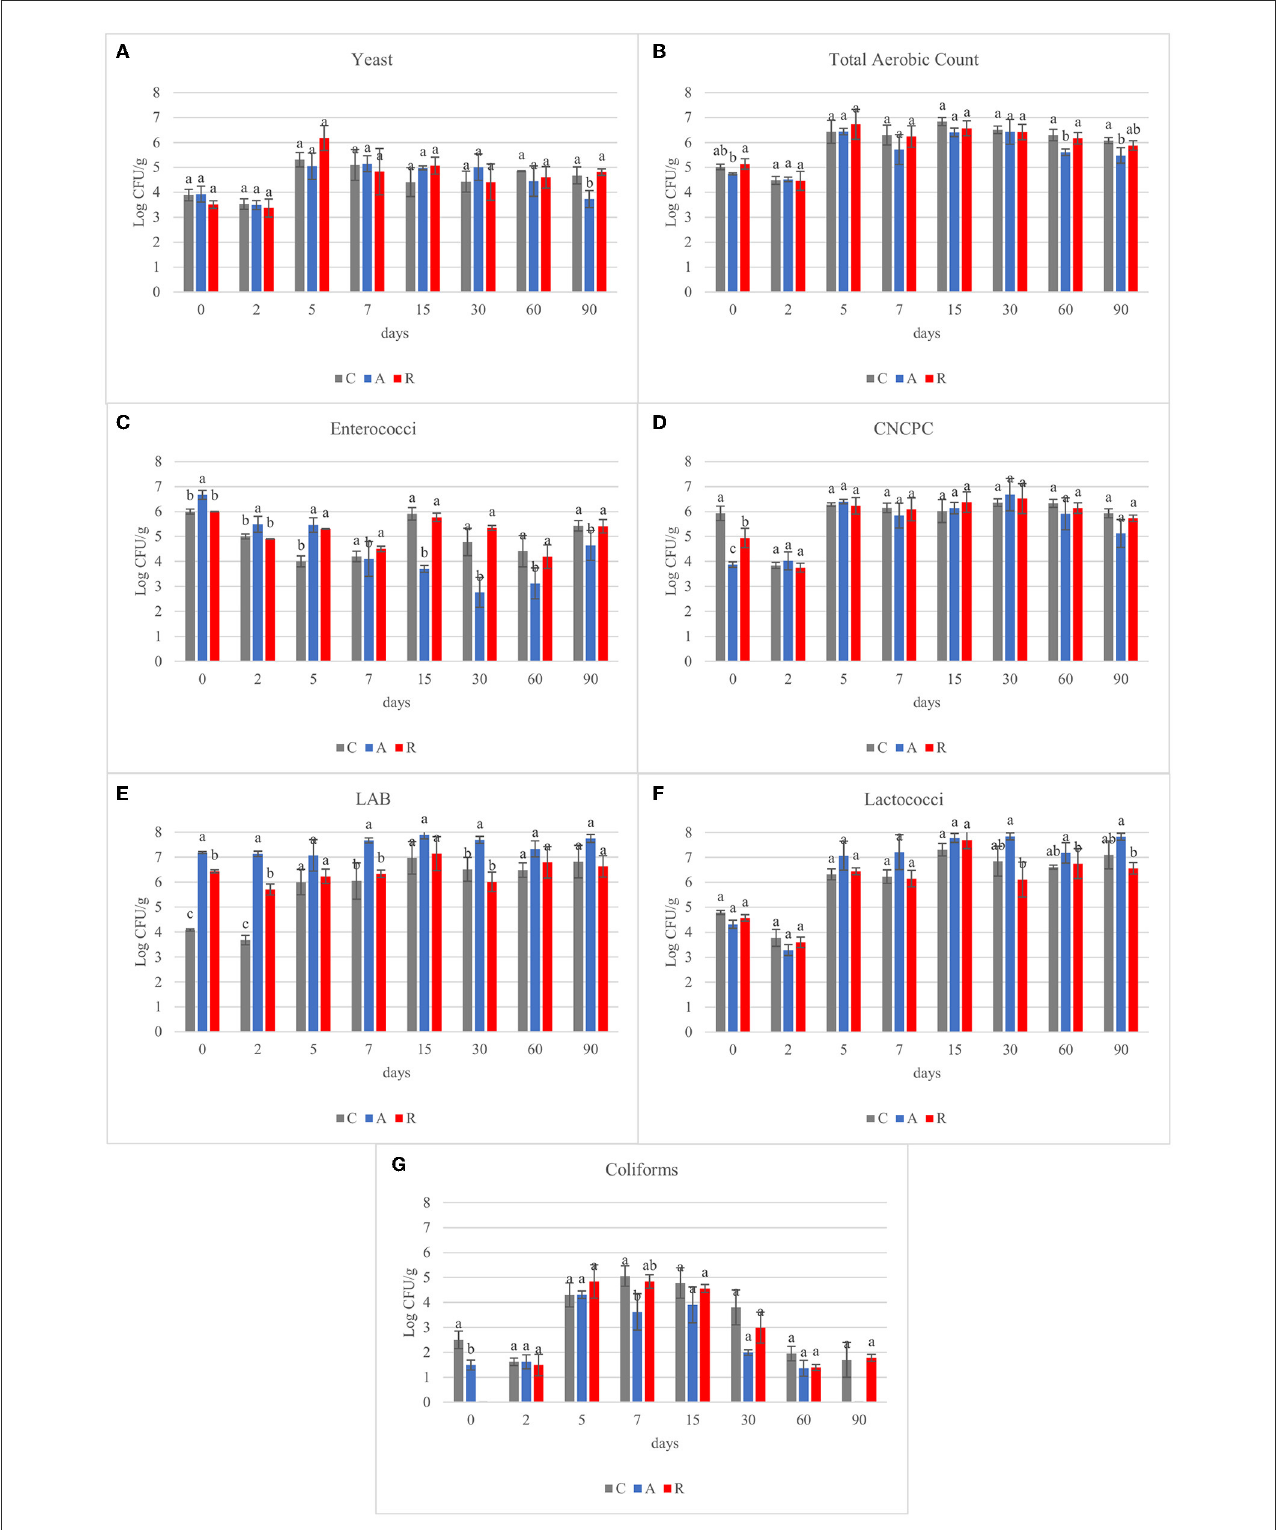
FIGURE1 Results of microbiological analysis of carried out on the fermented sausages (non-inoculated, C; inoculated with Lcb. casei N87 cultivated under respiratory conditions, A; inoculated with Lcb. casei N87 cultivated under anaerobiosis, R) during ripening (Log CFU/g). (A) yeast; (B) total aerobic count; (C) enterococci; (D) coagulase-negative catalase-positive cocci, CNCPC; (E) lactic acid bacteria, LAB; (F) lactococci; (G) coliforms. Error bars refer to the standard deviations obtained from triplicate sample analysis. ANOVA analysis with Tukey’s test was performed in samples, clustered according to microbial analysis and time of sampling. The results are showed as top letters on each